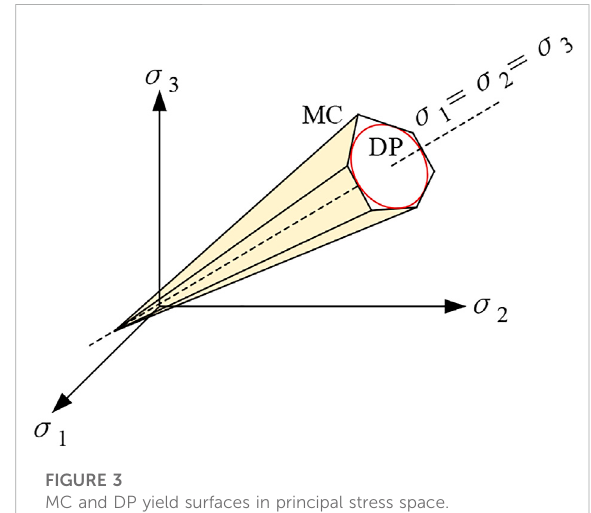
MC and DP yield surfaces in principal stress space.